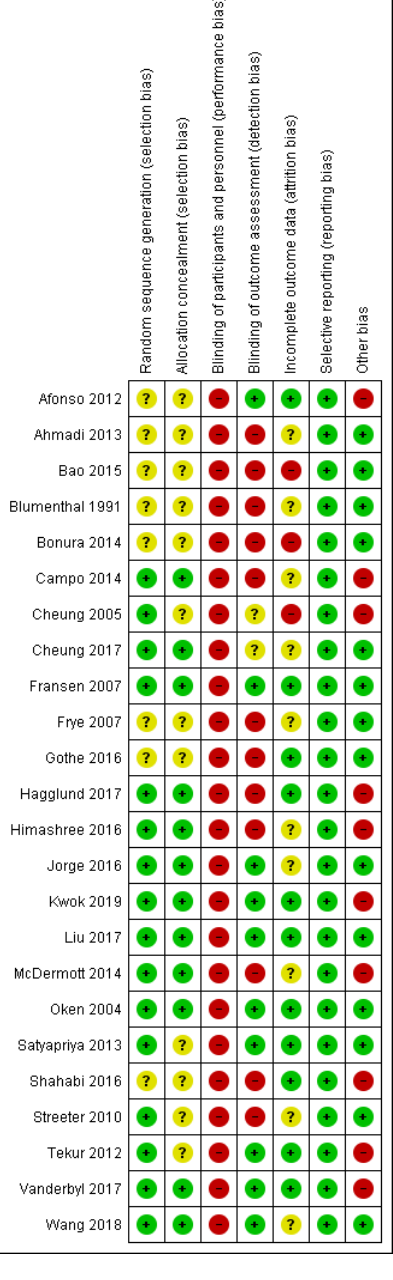
Figure 2. Summary of risk of bias.